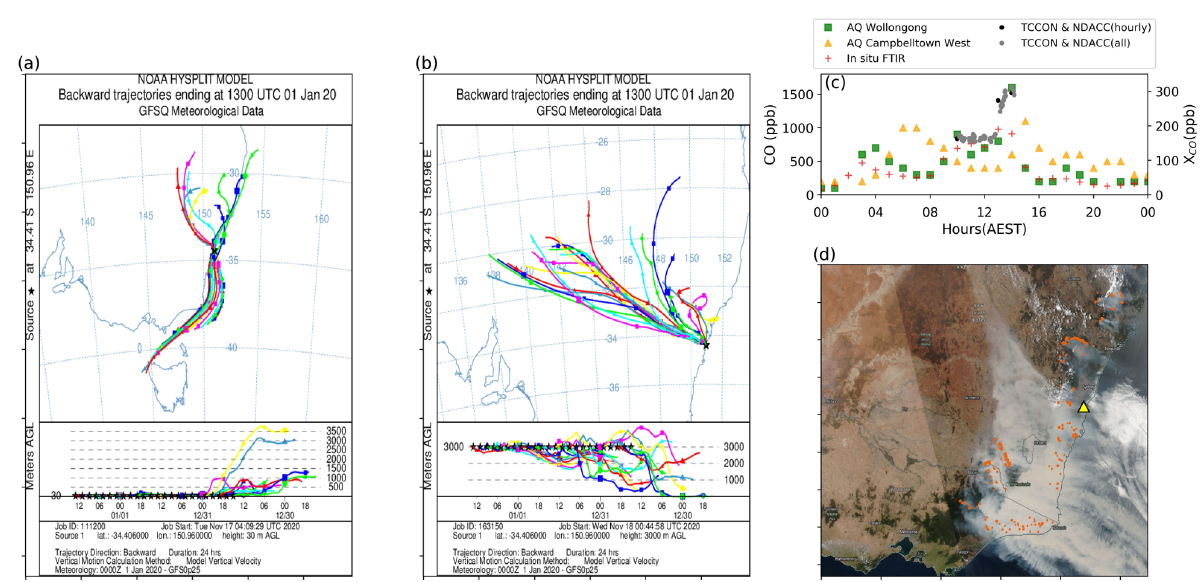
Figure 10. 1 January 2020: 24 h NOAA HYSPLIT back trajectories (UTC) at ( a ) 30 m and ( b ) 3000 m; ( c ) Hourly averaged surface in situ CO measurements at Wollongong air quality monitoring site (green squares), Campbelltown West air quality monitoring site (yellow triangles) and Wollongong in situ FTIR (red crosses). Black and grey dots show hourly averaged column CO measurements (TCCON & NDACC) and all native temporal resolution column measurements, respectively (in AEST: UTC + 10 h). ( d ) MODIS hotspot image with thermal anomalies [68] (zoomed in for southeast Australia). The UOW measurement site is marked with a yellow